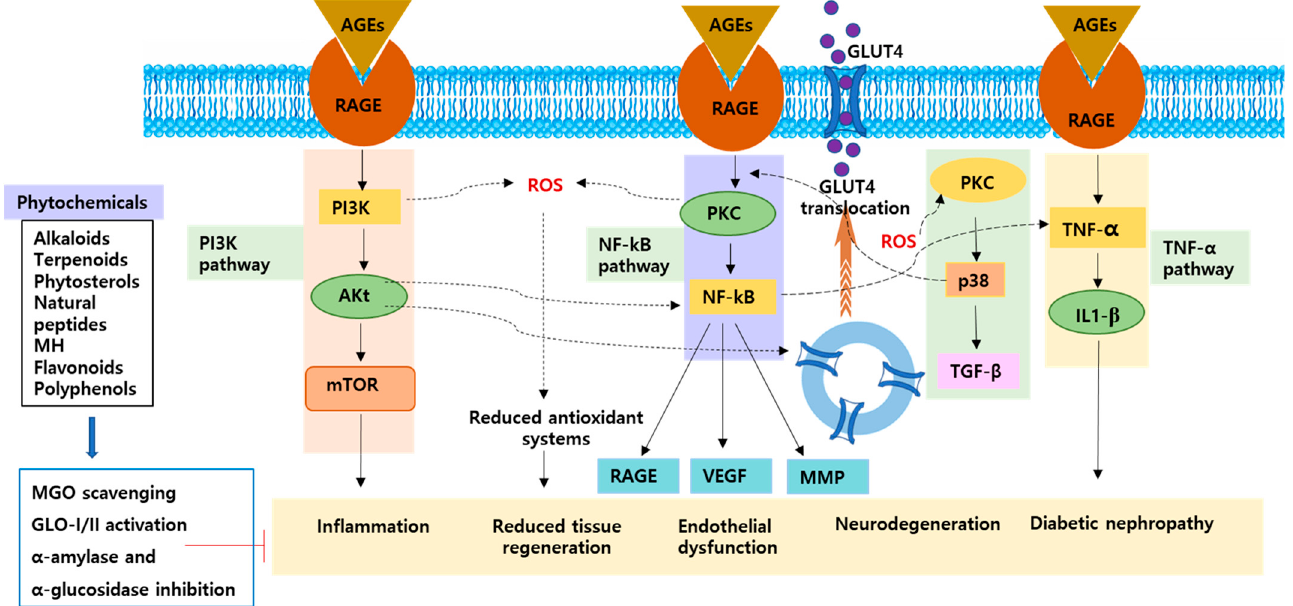
Figure 1. Inhibition of AGE-induced disease conditions by phytoconstituents. AGEs induce different molecular pathways leading to oxidative stress, inflammation, reduced tissue regeneration, ED, DN, and neurodegeneration. Phytochemicals inhibit or prevent these adverse effects by entrapping or scavenging MGO intracellularly. PI3K, NF-kB, and TNF- α signaling pathways are most commonly affected by AGE-induced ROS generation and oxidative stress that can be ameliorated by potential phytoconstituents.